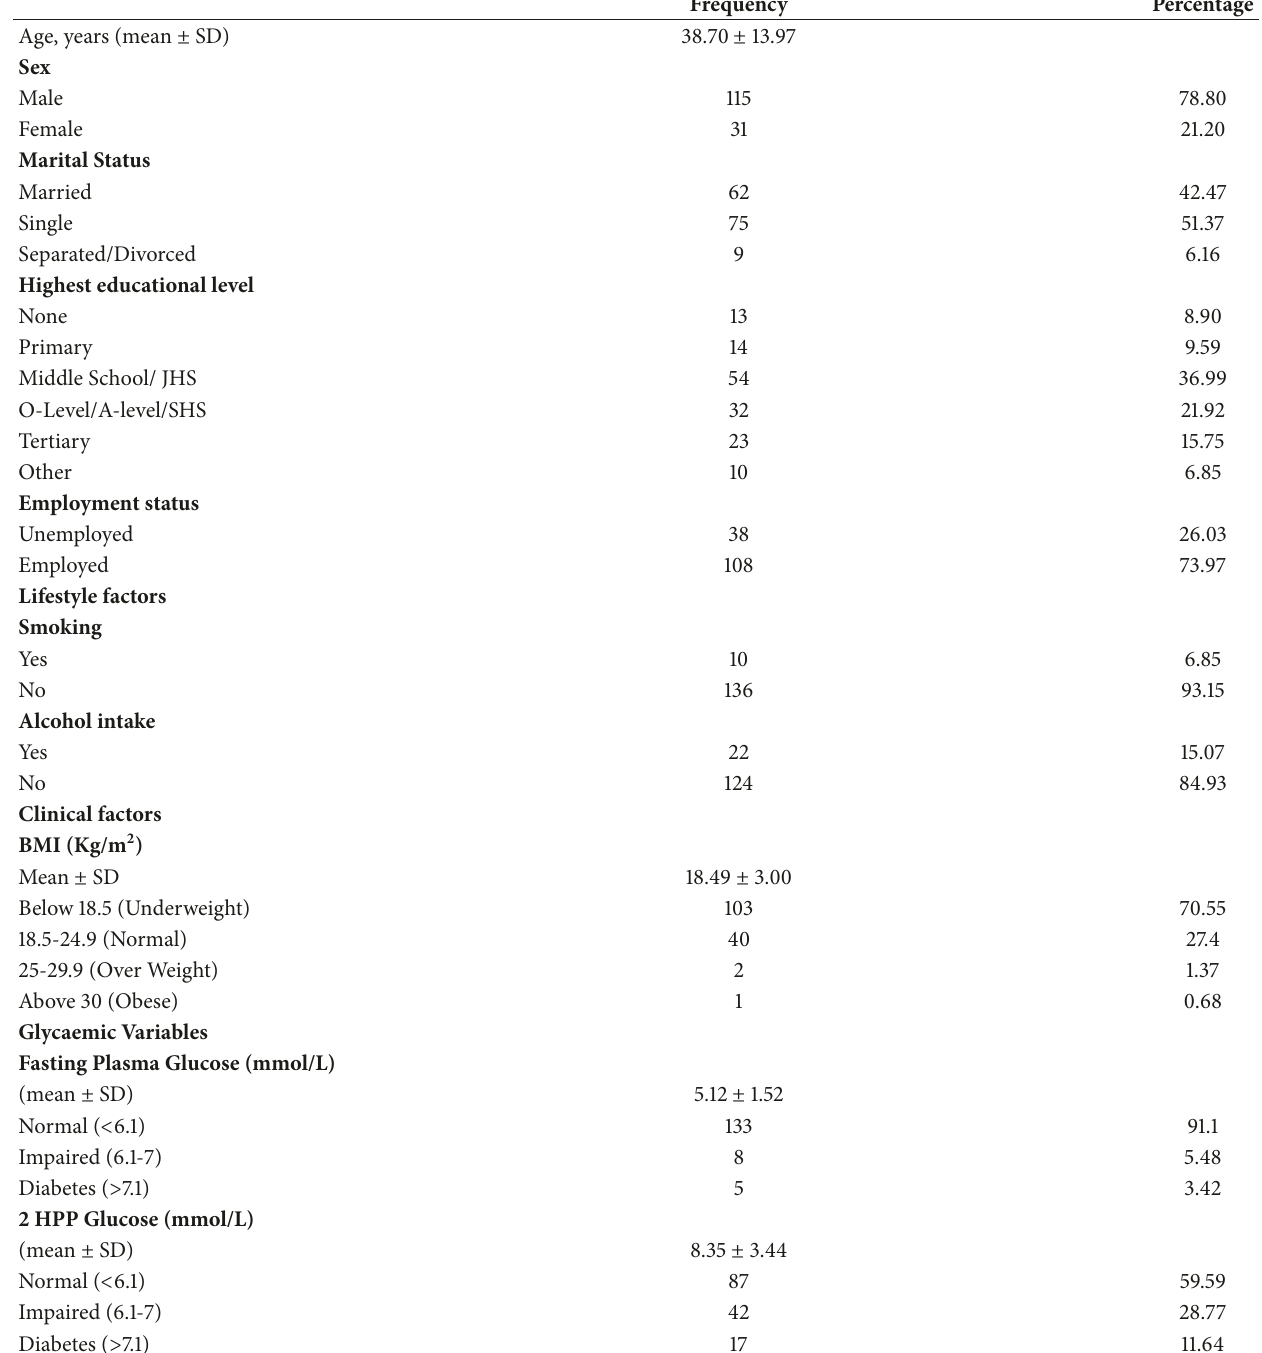
Table 1: Background characteristics of study